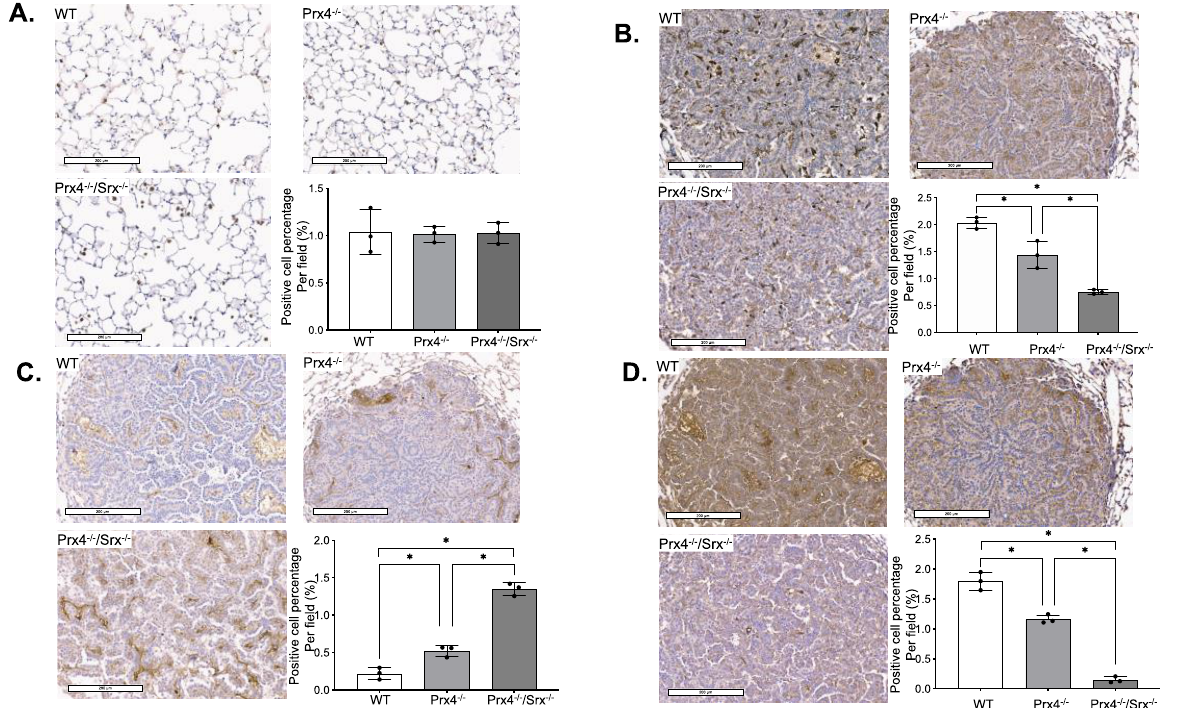
Figure 2. Prx4-Srx axis contributes to macrophage repolarization in the urethane-induced lung adenocarcinoma mouse model. ( A ) Anti-F4/80 staining of normal tissue from three genotypes and quantitative analysis of staining intensity. ( B ) Anti-F4/80 staining of tumor tissue from three genotypes and quantitative analysis of staining intensity. ( C ) Anti-CD86 staining of tumor tissue from three genotypes and quantitative analysis of staining intensity. ( D ) Anti-CD163 staining of tumor tissue from three genotypes and quantitative analysis of staining intensity. (*, p < 0.05).